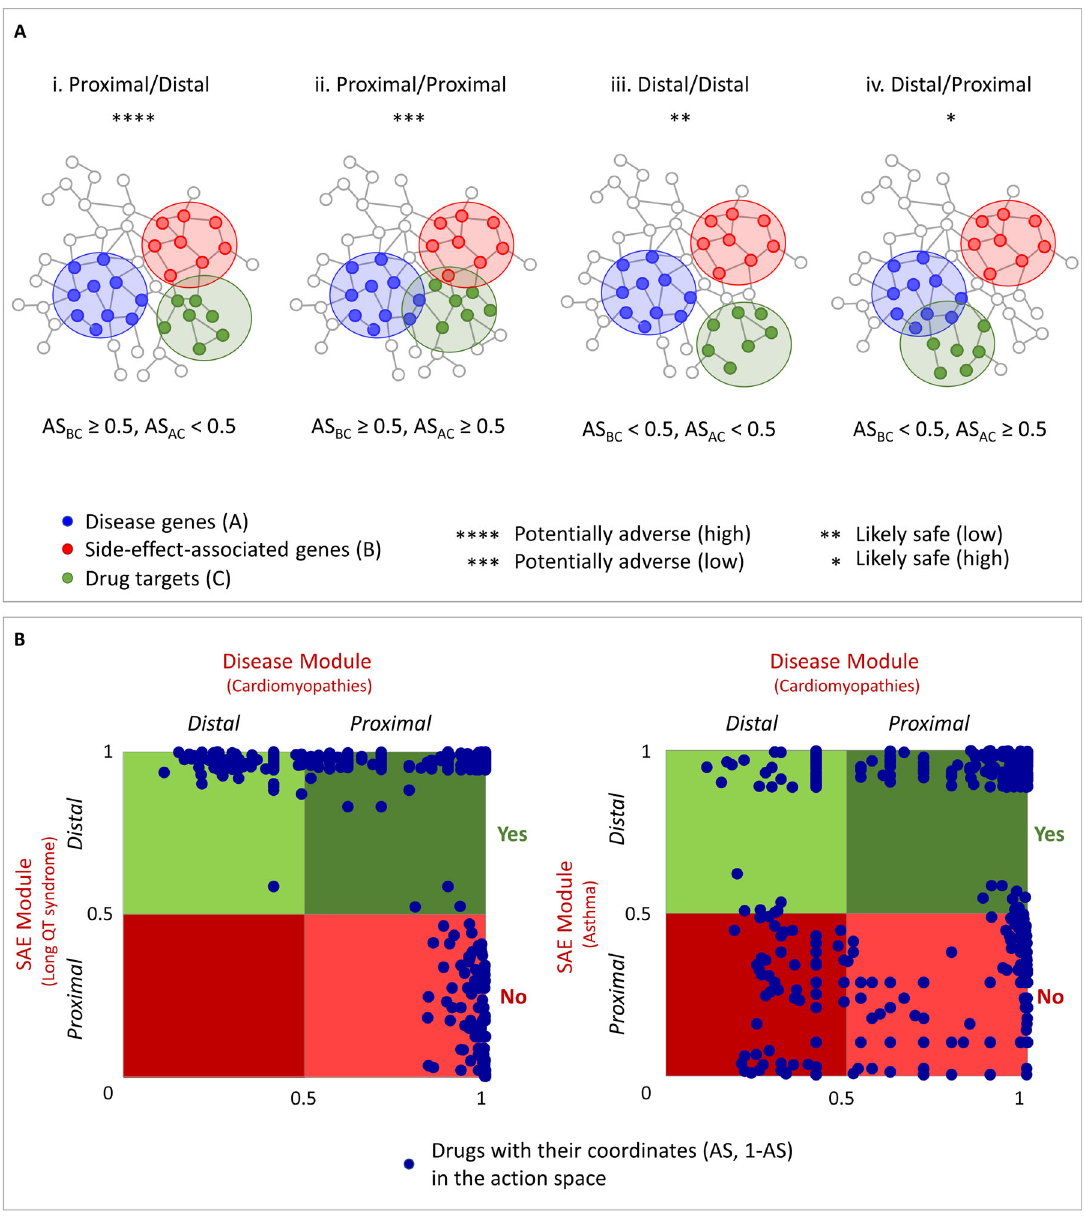
Fig. 5 Drug actions as function of distance of drug target to disease module or to serious adverse effect (SAE) module. A Drug target distance analysis. Four possible modes of action of the drug based on the distance of the drug module ( C ) to the disease module ( A ) and the SAE module ( B ) are depicted according to the corresponding adjusted similarity value (AS). Stars indicate severe/bene fi cial effects of the different drug ’ s mode-of-action. B Drug-action map. Scatter plot of AS for the disease module (i.e., cardiomyopathies) on the x -axis, and (1-AS) for SAE module (i.e., [left] long QT syndrome, [right] drug-induced asthma) on the y -axis. The four possible modes of action are colored with shades of red and green according to their predicted adverse or bene fi cial effects, syndrome and sudden cardiac death, it is well-known that pre- relationship would be preferred. However, the complex drug/ existing cardiomyopathy puts one at increased risk of sudden disease/side-effect interactions (not directly accounted for in the death from non-cardiac drug-induced QT interval prolongation 29 model) may mitigate this interpretation in some circumstances, viz ., that a side-effect may become apparent that was not (positive synergism), and network analysis provides a molecular previously recognized (positive synergy) or a known side-effect mechanism by which to explain this synergistic adversity. may be attenuated (negative synergy), in both cases because the The predictions of our pipeline show a very different pattern for drug target is close to both the (repurposed) disease module and potentially repurposable drugs for cardiomyopathies vs. long QT to the side-effect module. In this sense, the light red quadrant of syndrome (Fig. 5B, left) or asthma (Fig. 5B, right). In the case of the action diagram (Fig. 5B) corresponding to the proximal/ long QT syndrome, we observed a lack of drugs populating the proximal mode-of-action, can highlight a unique side-effect risk proximal/distal mode of action (i.e., dark red region in Fig. 5B, left), that re fl ects (positive or negative) synergism between the side- with the distribution of the adjusted similarity values with respect effect and the disease. For example, in the case of long QT to cardiomyopathies is less sparse and densi fi ed at the top of the